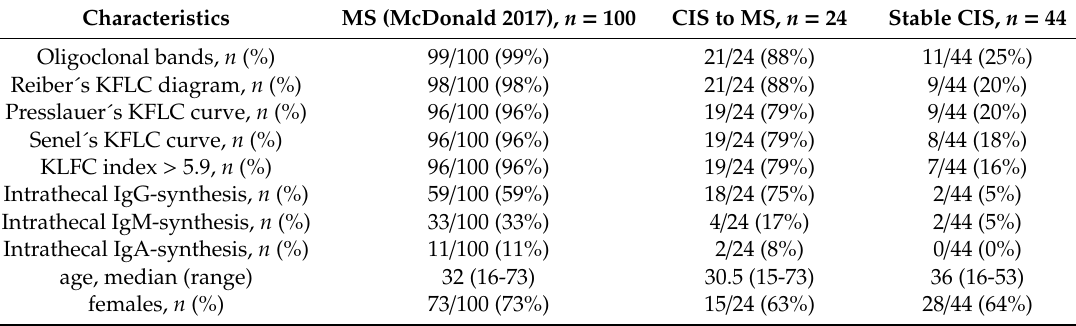
Table 1. Demographic and laboratory characteristics of patients diagnosed with MS according to the McDonald criteria of 2017, CIS who converted to MS during follow up and patients with stable CIS. Laboratory characteristics include the determination of oligoclonal bands, the kappa free light chains index and the proportion of an intrathecal synthesis of KFLC by using the methods of Reiber, Presslauer, and Senel